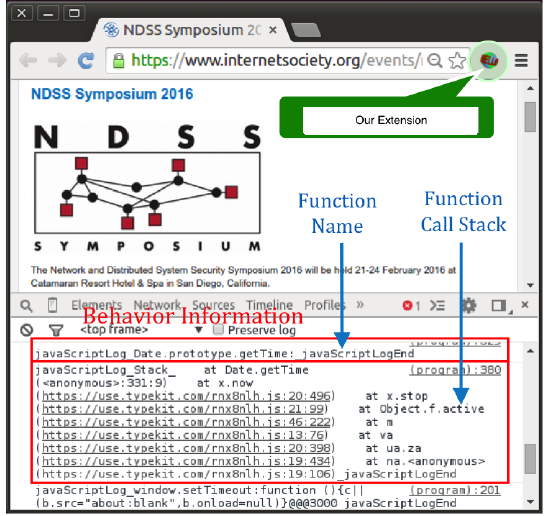
Figure 3. Runtime snapshot of our approach. Website behavior information is logged into the browser